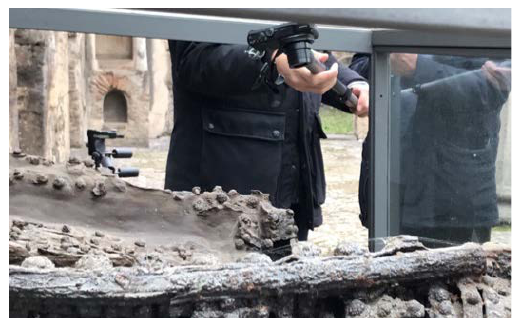
Figure 6. One operator during the survey holding the camera- monopod system inside the glass case.